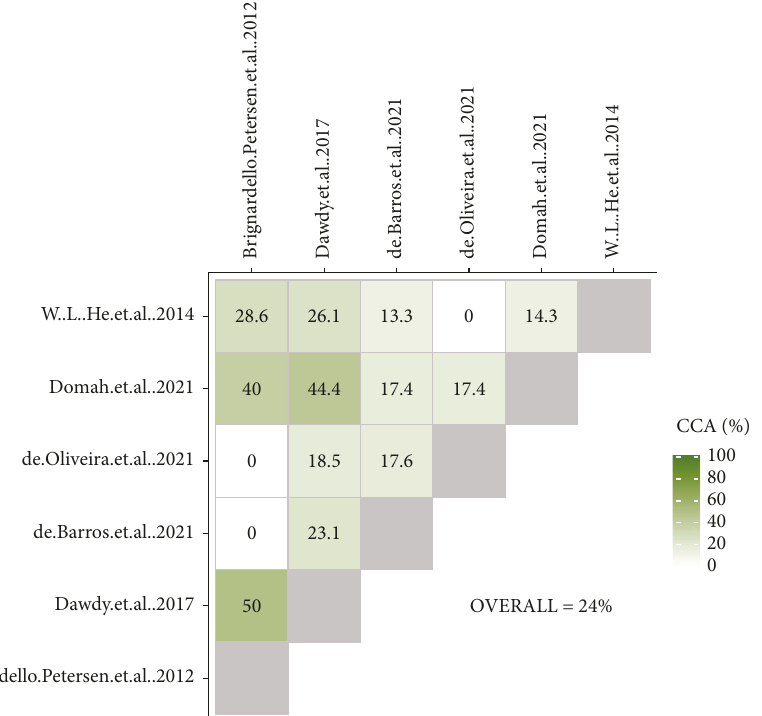
Figure 5: CCA grids of meta-analyses evaluating the effectiveness of low-level laser therapy in reducing pain after third molar surgery. Meta-Analyses Dawdy et al. 2017 Domah et al. 2021 de Oliveira et al. 2021 de Barros et al. 2021 W. L. He et al. 2014 Brignardello-Petersen et al. 2012 Abdel-Alim et al.